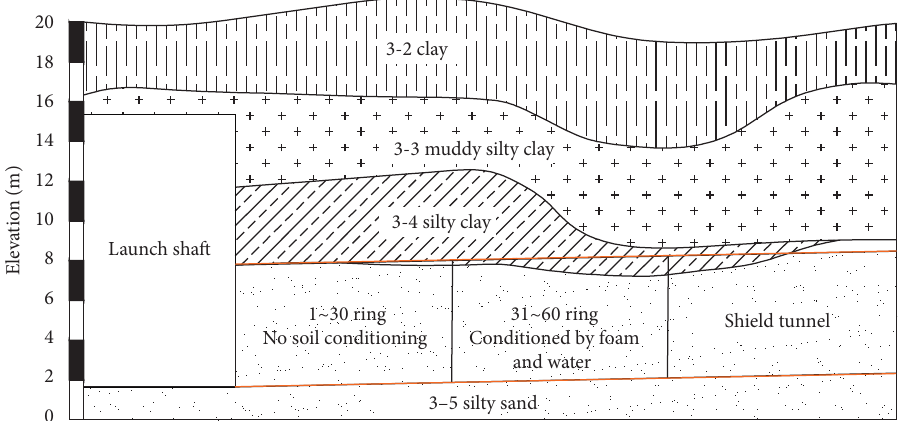
Figure 8: Geological profile of the experimental tunnel.